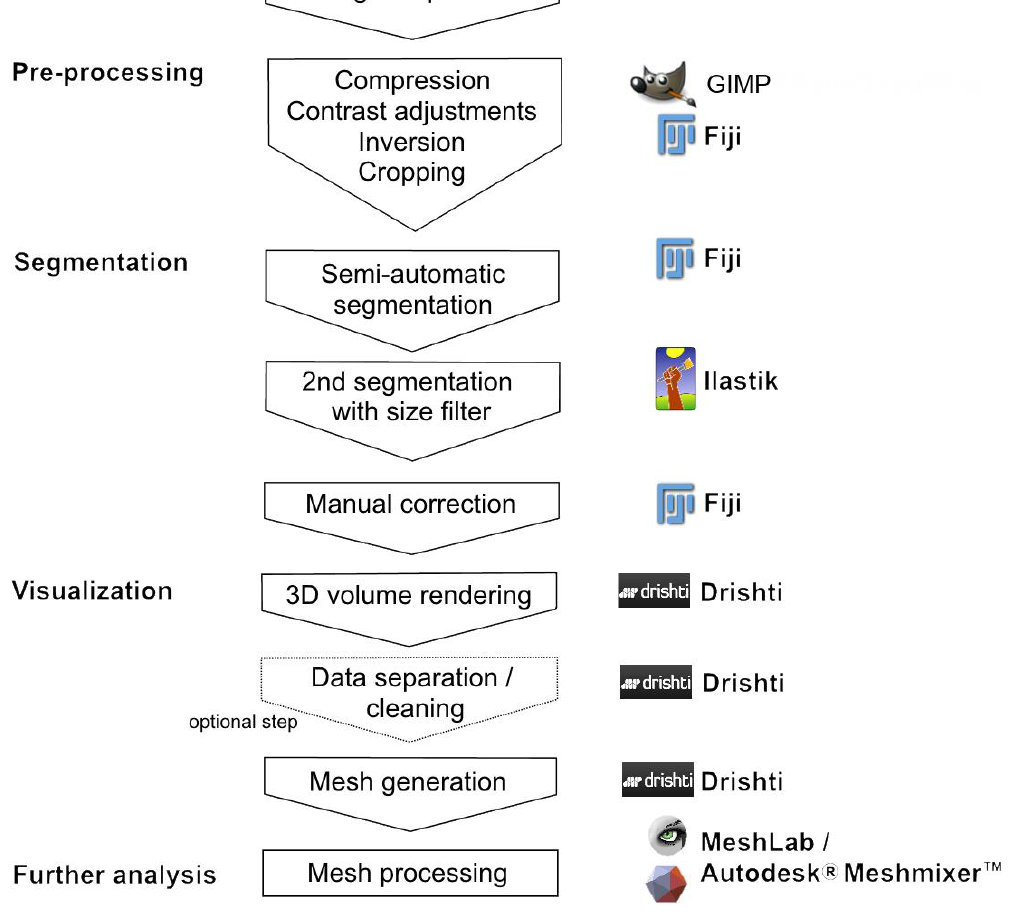
Figure 3. Workflow diagram of the image analysis with open-source software.